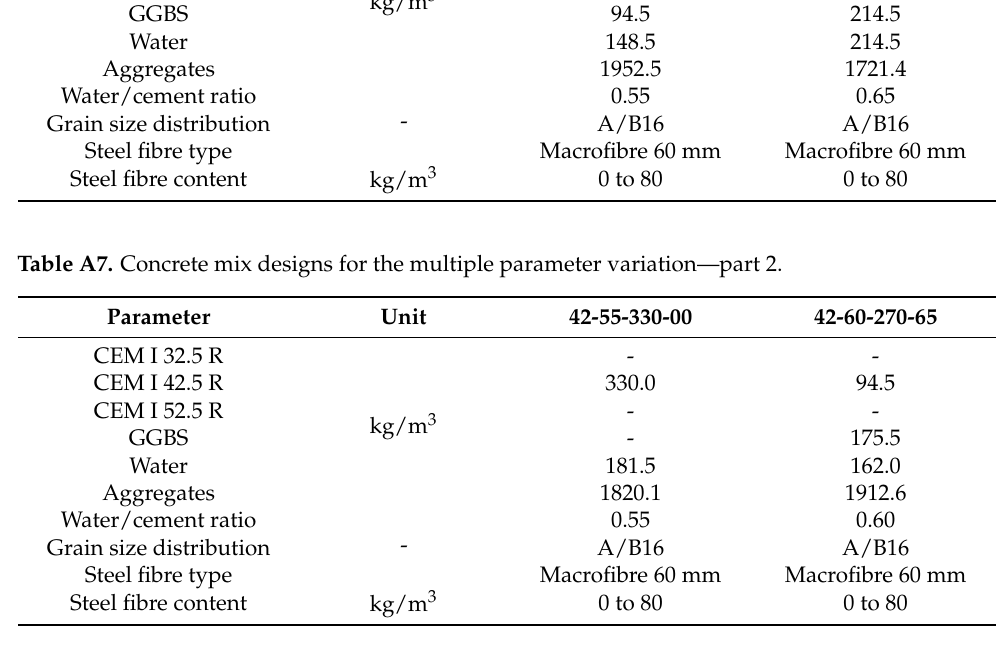
Table A8. Concrete mix designs for the multiple parameter variation—part